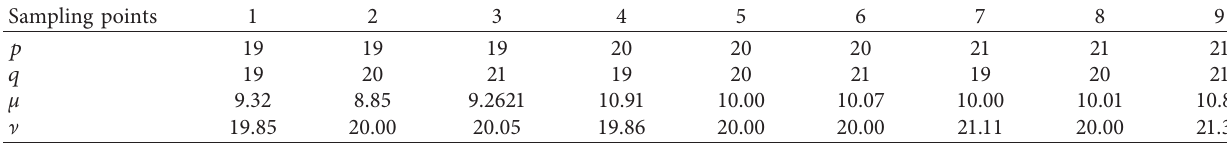
Table 3: Polarization state in the region of the main lobe.